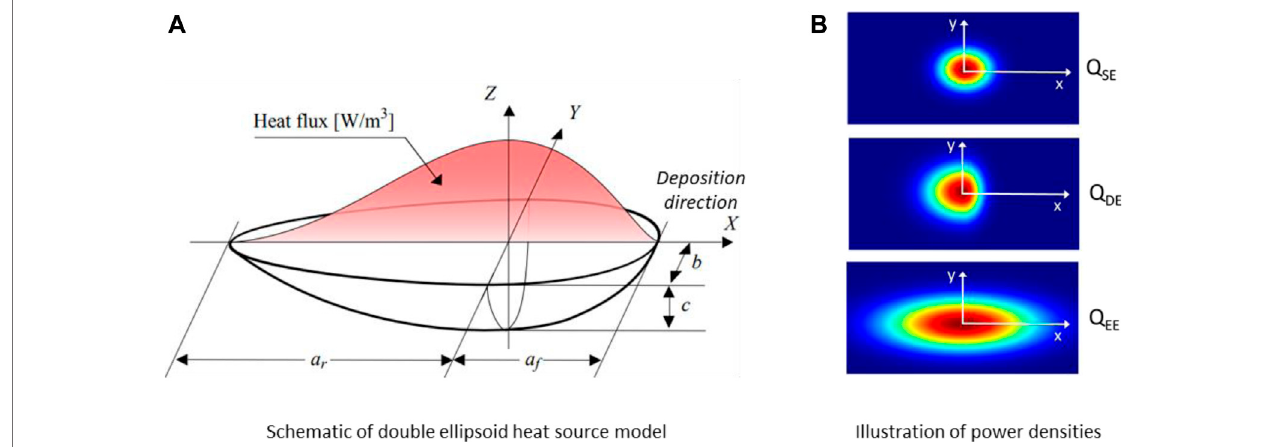
FIGURE 1 | (A) Double ellipsoid (DE) heat source model comprised of two ellipsoids, if a f (cid:2) a r it functions as single ellipsoid (SE), (B) Comparison of moving Single Ellipsoid (top) with Double Ellipsoid (centre) and Elongated Ellipsoid (bottom) heat source